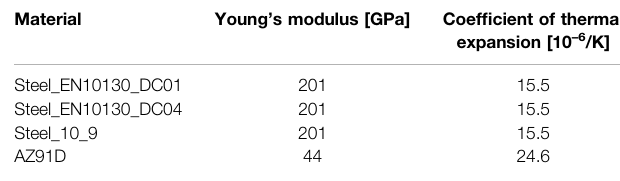
TABLE 1 | Material elastic properties used in the FE